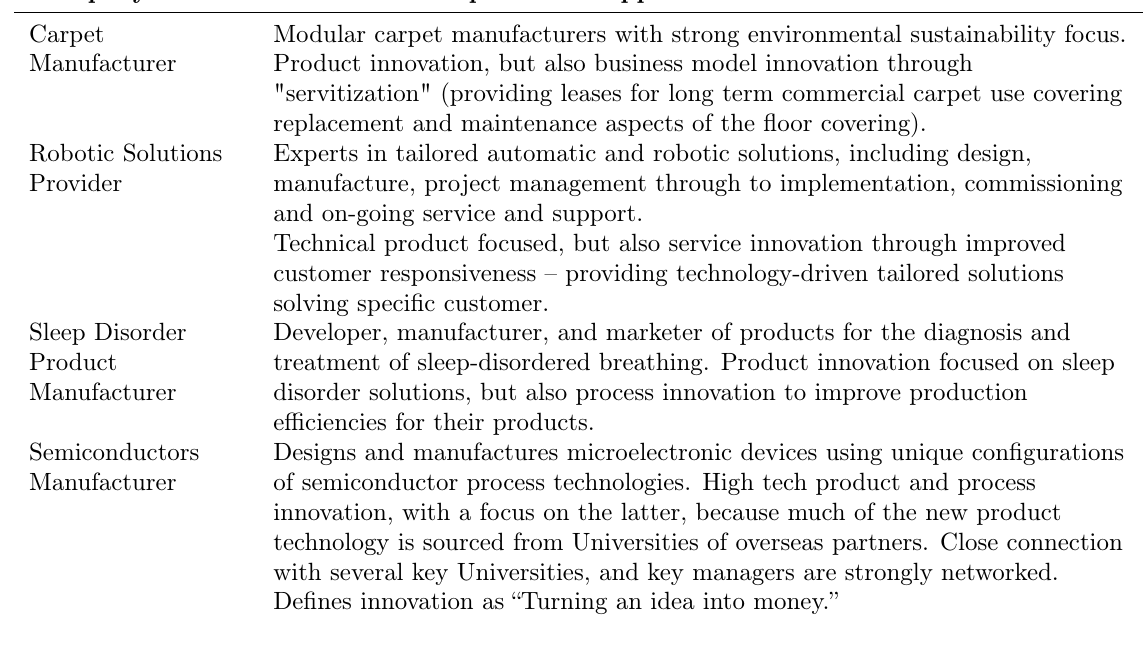
Table 4. Approaches to business and innovation adopted by a selection of the SME